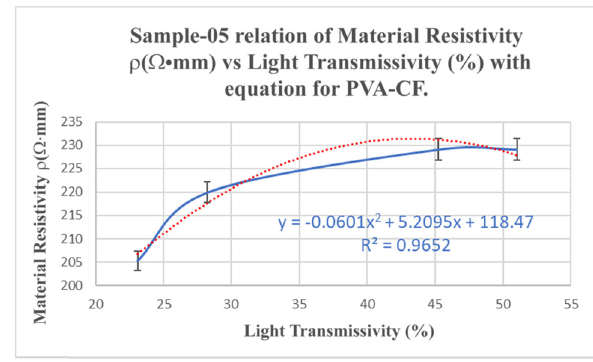
Figure 29: Sample - 04 ( CF:PVA = 0.6:30 ) material resistivity ρ ( Ω mm ) versus light transmittance ( % ) with equation for PVA - CF. The dotted lines represent the polynomial fi tted curve and the linear